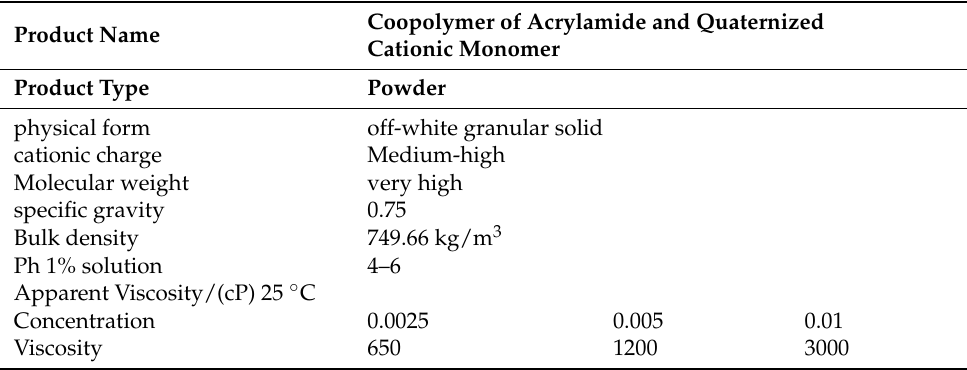
Table 2. Polymer technical properties from